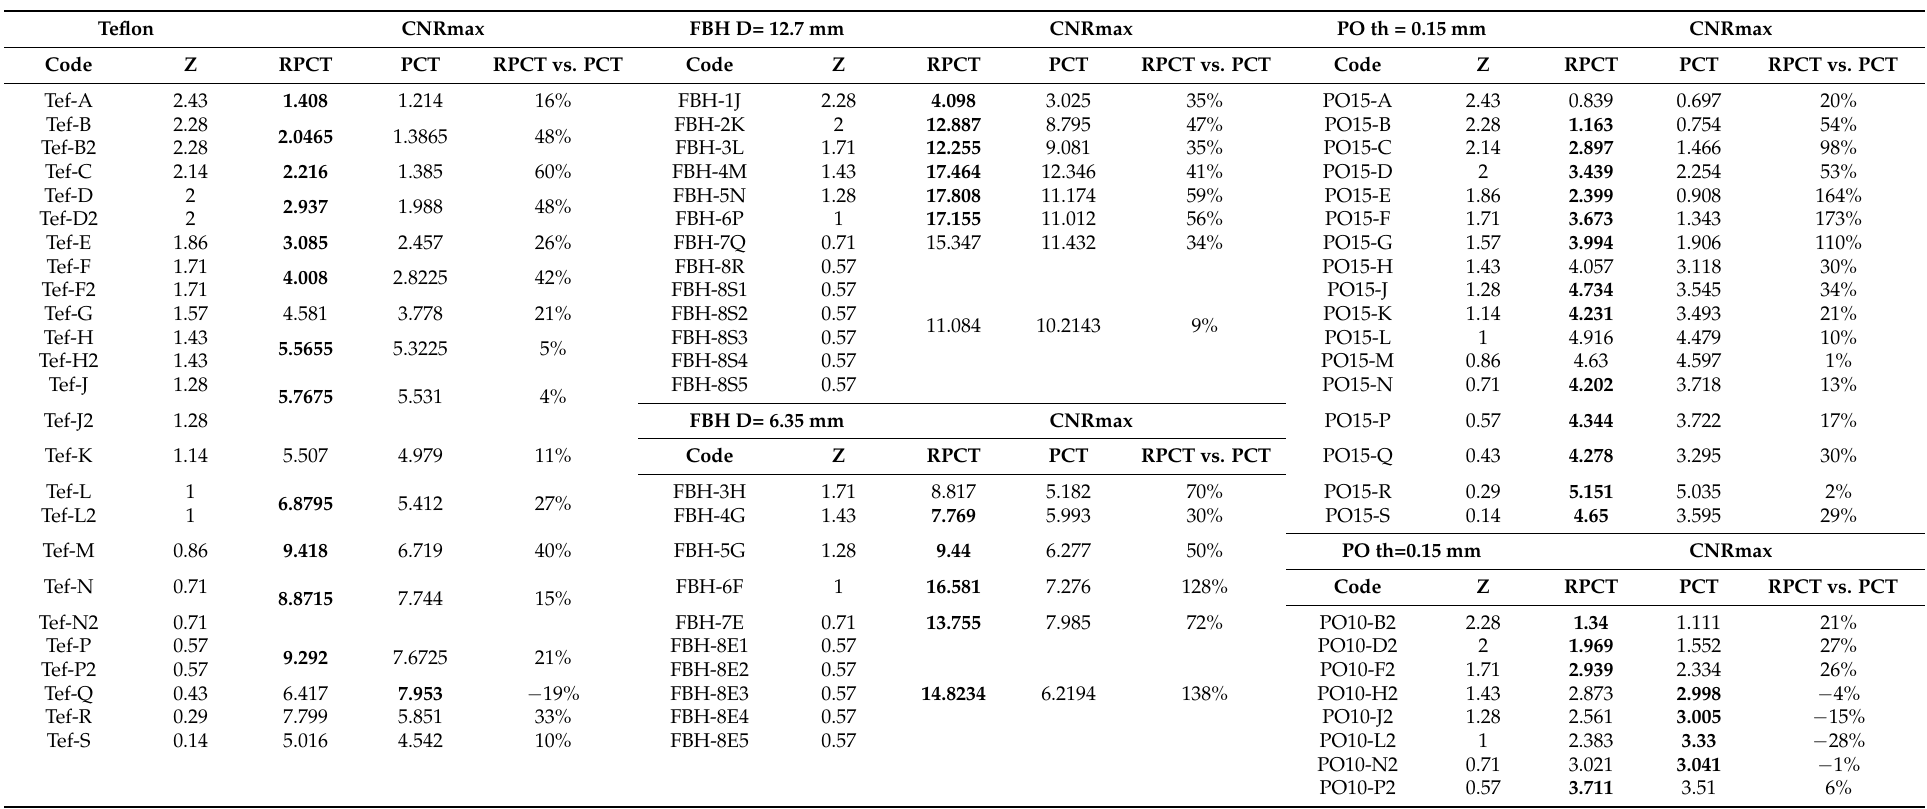
Table 3. Maximum CNR (CNRmax) values for RPCT and PCT methods in all depths